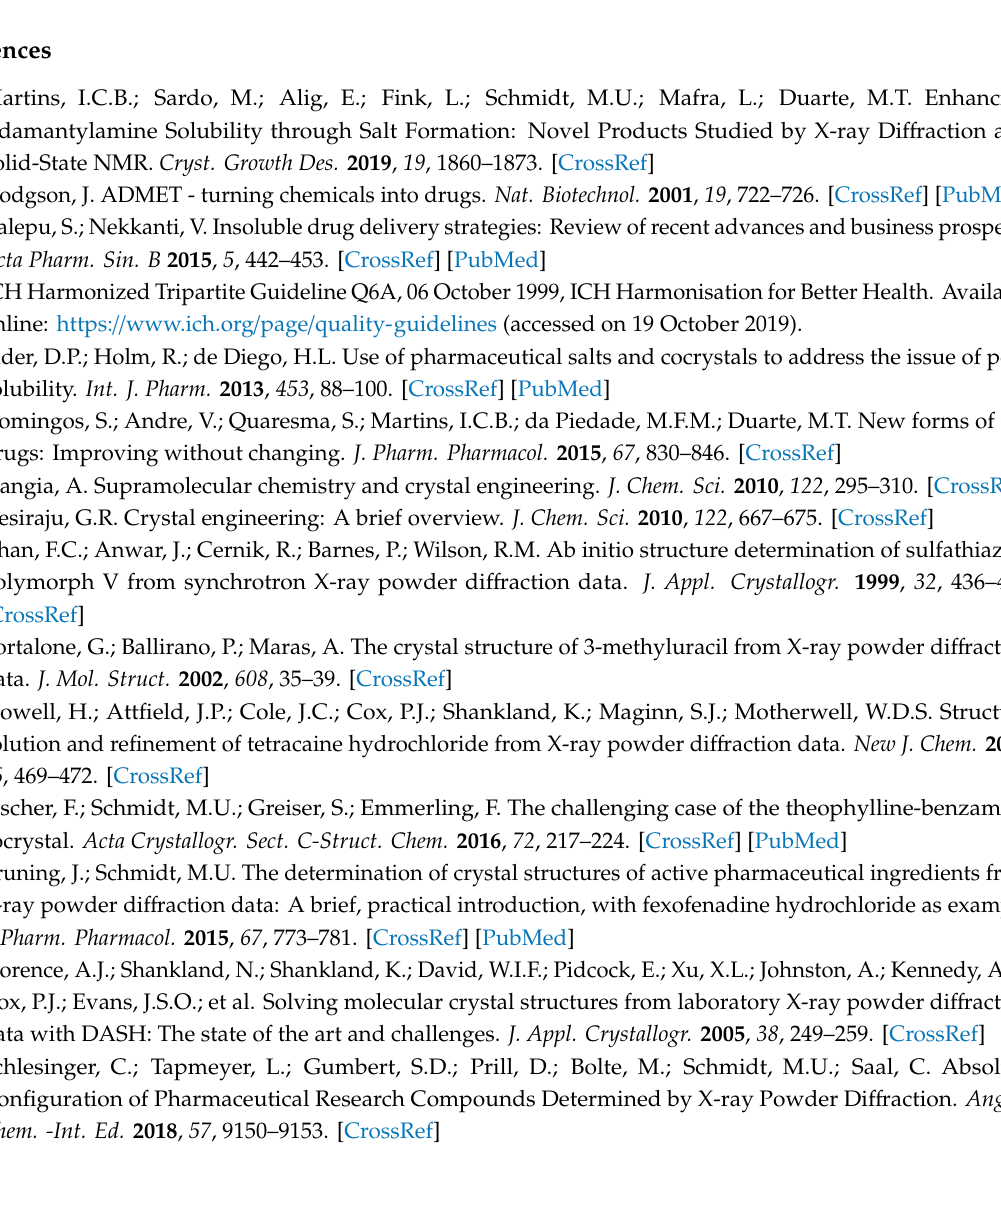
Table S1: Experimental and calculated 13 C NMR CSs of SA:IMI, Table S2: Experimental and calculated 1 H NMR CSs of SA:1-MEIM, Table S3: Experimental and calculated 13 C NMR CSs of SA:1-MEIM, Table S4: Experimental and calculated 13 C NMR CSs of SA:2-MEIM, Figure S1: Raman spectra of SA, Figure S2: Raman spectra of SA:IMI, Figure S3: Raman spectra of SA:1-MEIM, Figure S4: Raman spectra of SA:2-MEIM, Figure S5: 1 H MAS NMR spectra of SA:IMI, Figure S6: 13 C CP-MAS NMR spectra of SA:IMI, Figure S7: 1 H MAS NMR spectra of SA:1-MEIM, Figure S8: 13 C CP-MAS NMR spectra of SA:1-MEIM, Figure S9: 1 H MAS NMR spectra of SA:2-MEIM, Figure S10: 13 C CP-MAS NMR spectra of SA:2-MEIM, Figure S11: DTA curve of SA:IMI, Figure S12: DTA curve of SA:1-MEIM and Figure S13: DTA curve of